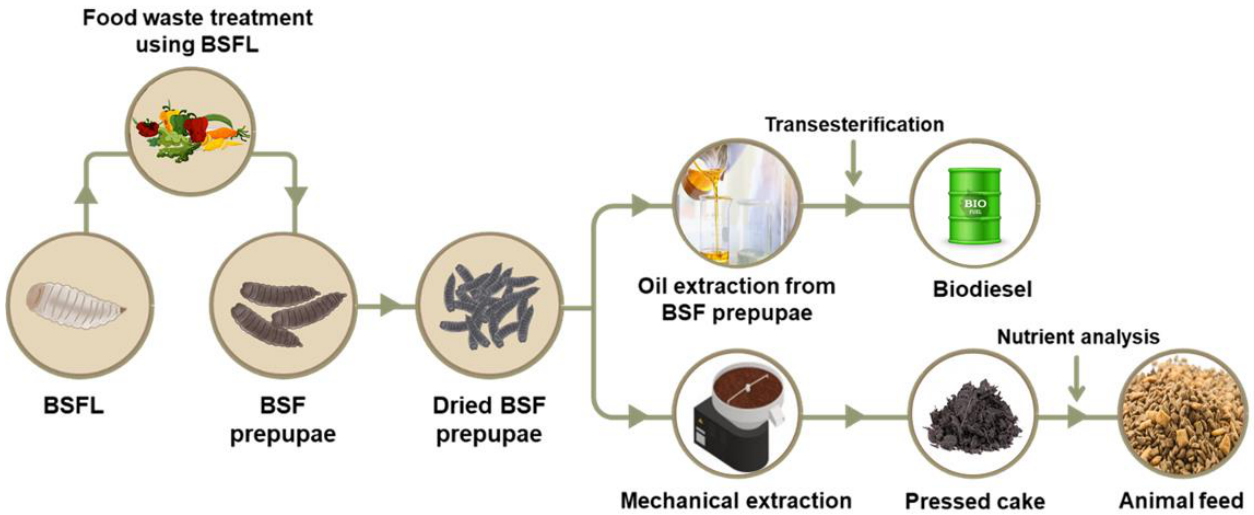
Figure 3. Process of food waste treatment using BSFL and production of biodiesel and animal feed from BSF (modified from [68]). Table 2. Summary of treatment efficiencies of various food wastes by BSFL. Substrate reduction ratio: ratio between the amount of substrate reduced after the treatment and initial amount of substrate; biomass conversion ratio: ratio between total dry matter weight of prepupae and that of prepupae plus substrate; protein conversion ratio: ratio between total amount of protein in dry matter of prepupae and that of prepupae plus substrate. NA: Not available.